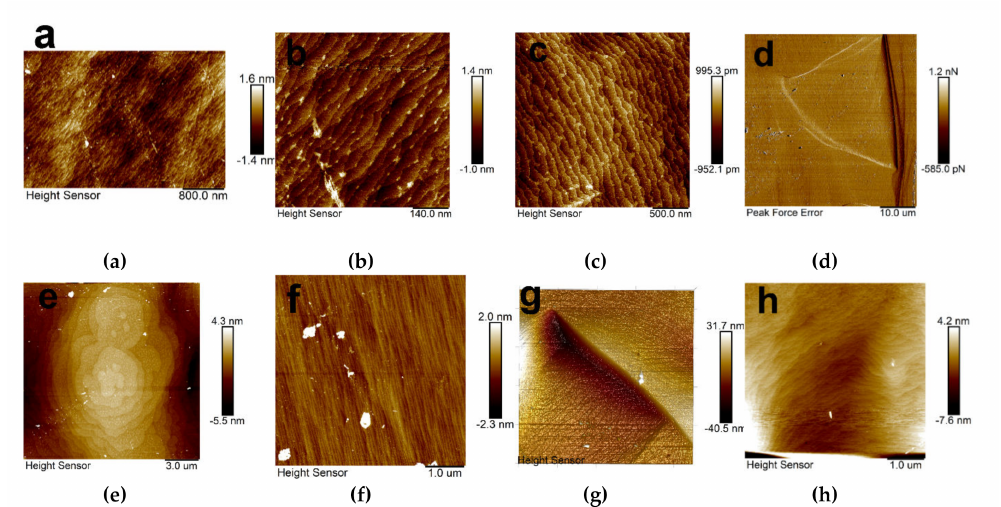
Figure 3. Microtopography of (101) faces of KDP crystals grown in [101] direction under low supersaturation: ( a ), ( b ) σ = 0.37%; ( c ), ( d ), ( e ) σ = 0.74%; ( f ), ( g ), ( h ) σ = 1.87%.